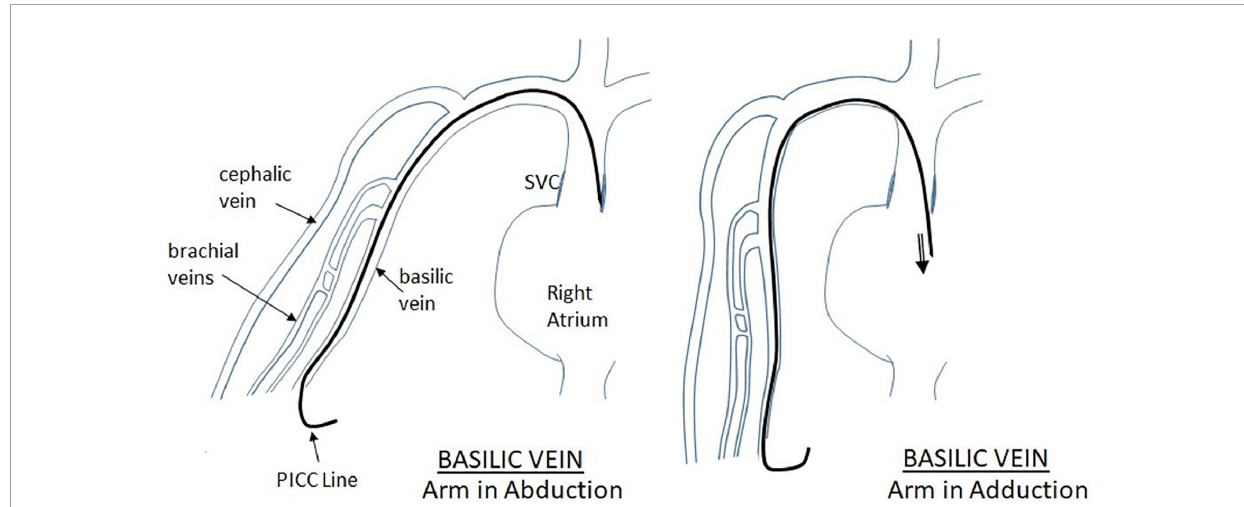
FIGURE5 Displacement of PICC inserted through the Basilic vein during arm movement. When the arm is moved from abduction position to adduction, there is tendency for the PICC to move inward toward the heart. This should be considered during the final PICC